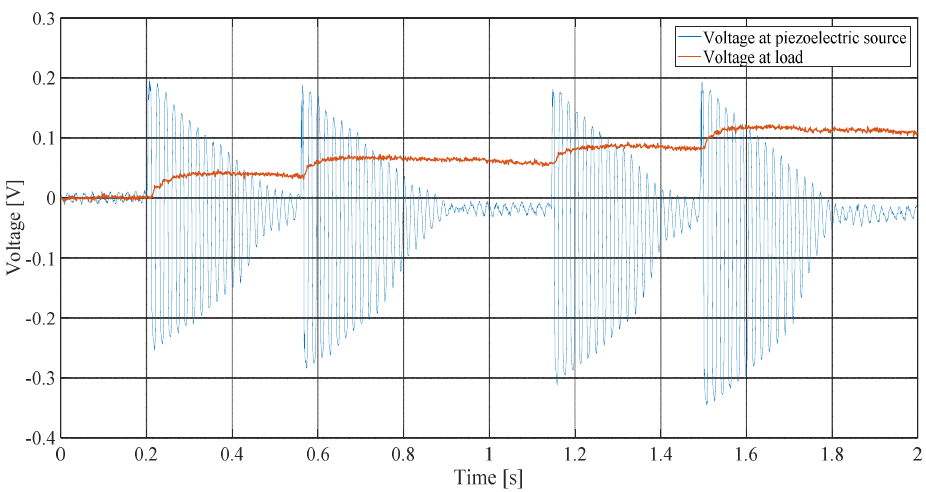
Figure 22. Transient voltage obtained for Greinacher rectifying circuit.